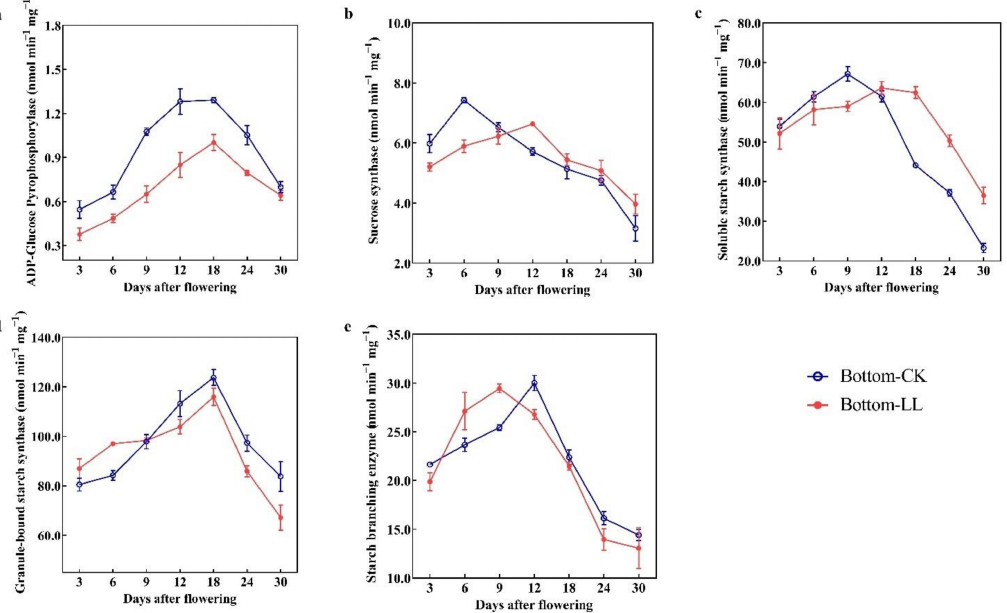
Figure 3. Activities of ADP-glucose pyrophosphorylase ( a ), sucrose synthase ( b ), soluble starch synthase ( c ), granule-bound starch synthase ( d ) and starch branching enzyme ( e ) in rice grains under LL in 2021. Bottom, bottom panicle part; CK, full sunlight (control); LL, low light stress.